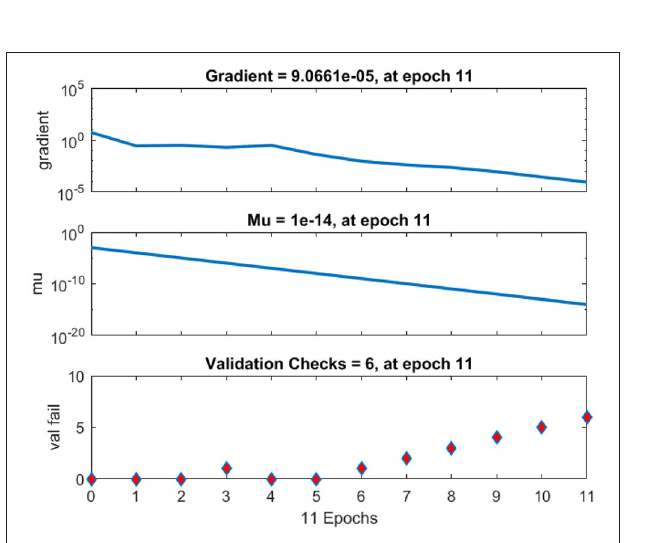
FIGURE 13 | Regression analysis of neural network based on the ID function model of the neuron.